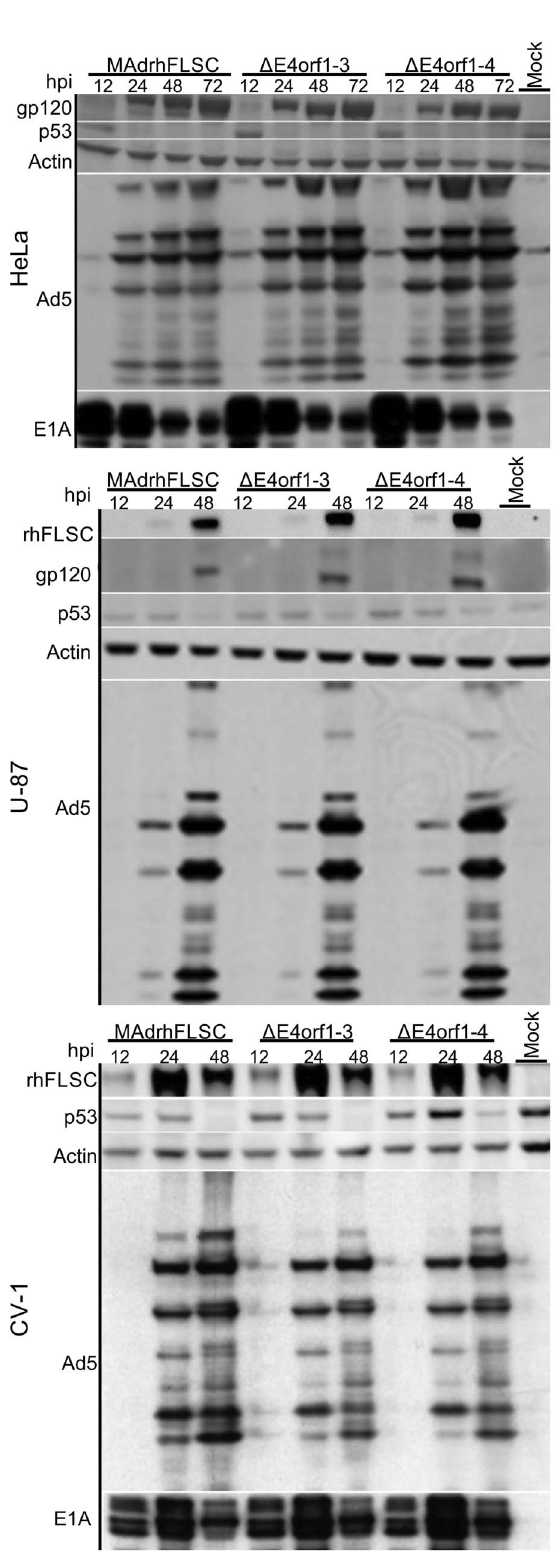
Figure 6. The transgene accumulates during the late phase of the virus infection cycle. HeLa, U-87, and CV-1 cells were plated and the day after infected at an MOI of 5–50 PFU/cell with the indicated viruses. At various times post infection the cells were lysed directly in 1X boiling protein sample buffer and the total cell lysates were analyzed by western blot using either anti-gp120, anti-CD4, anti-p53, anti-actin,